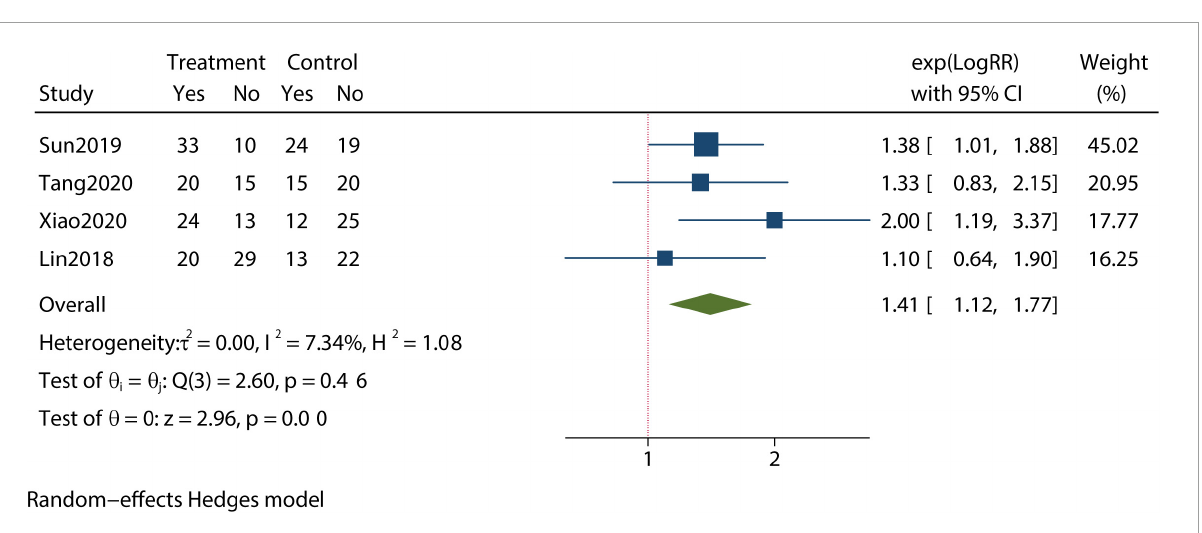
FIGURE6 Meta-analysis of pregnancy